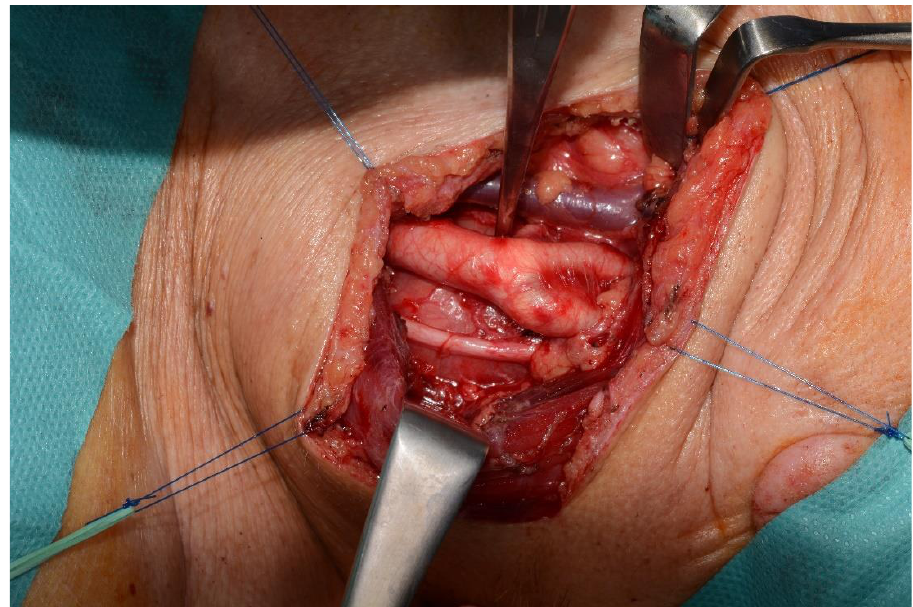
Figure 4. Lateral retraction of the sternocleidomastoid muscle. Underneath the vagus nerve, carotid artery (lateral), and internal jugular vein, the tumoral mass can be observed.